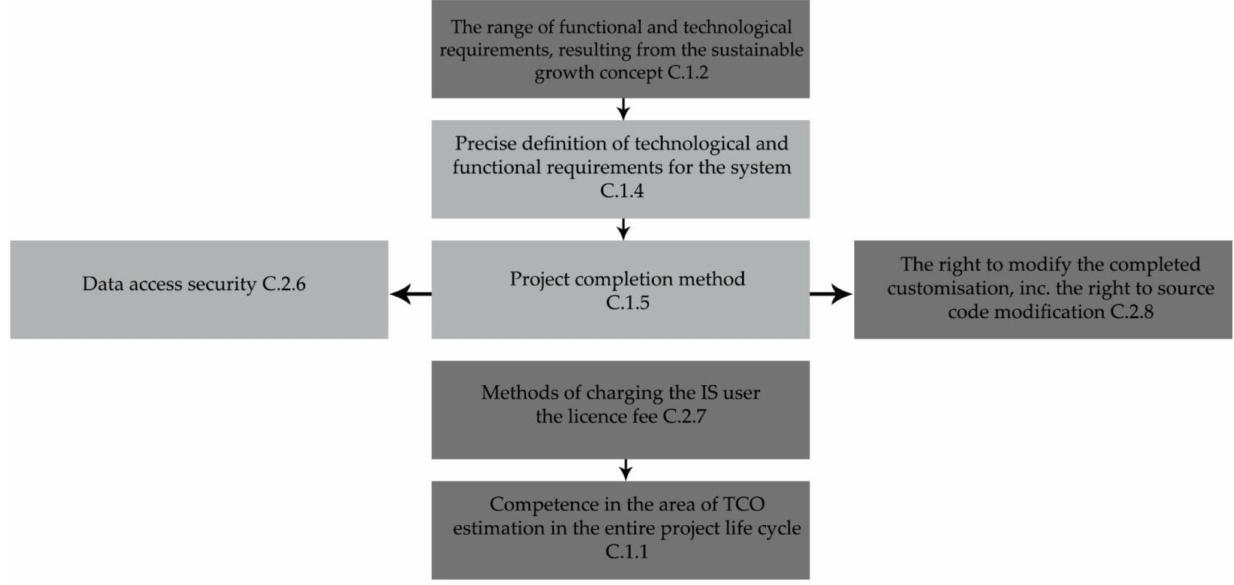
Figure 1. Inheriting information gaps for the relevant components in Stage 1. Source: Own